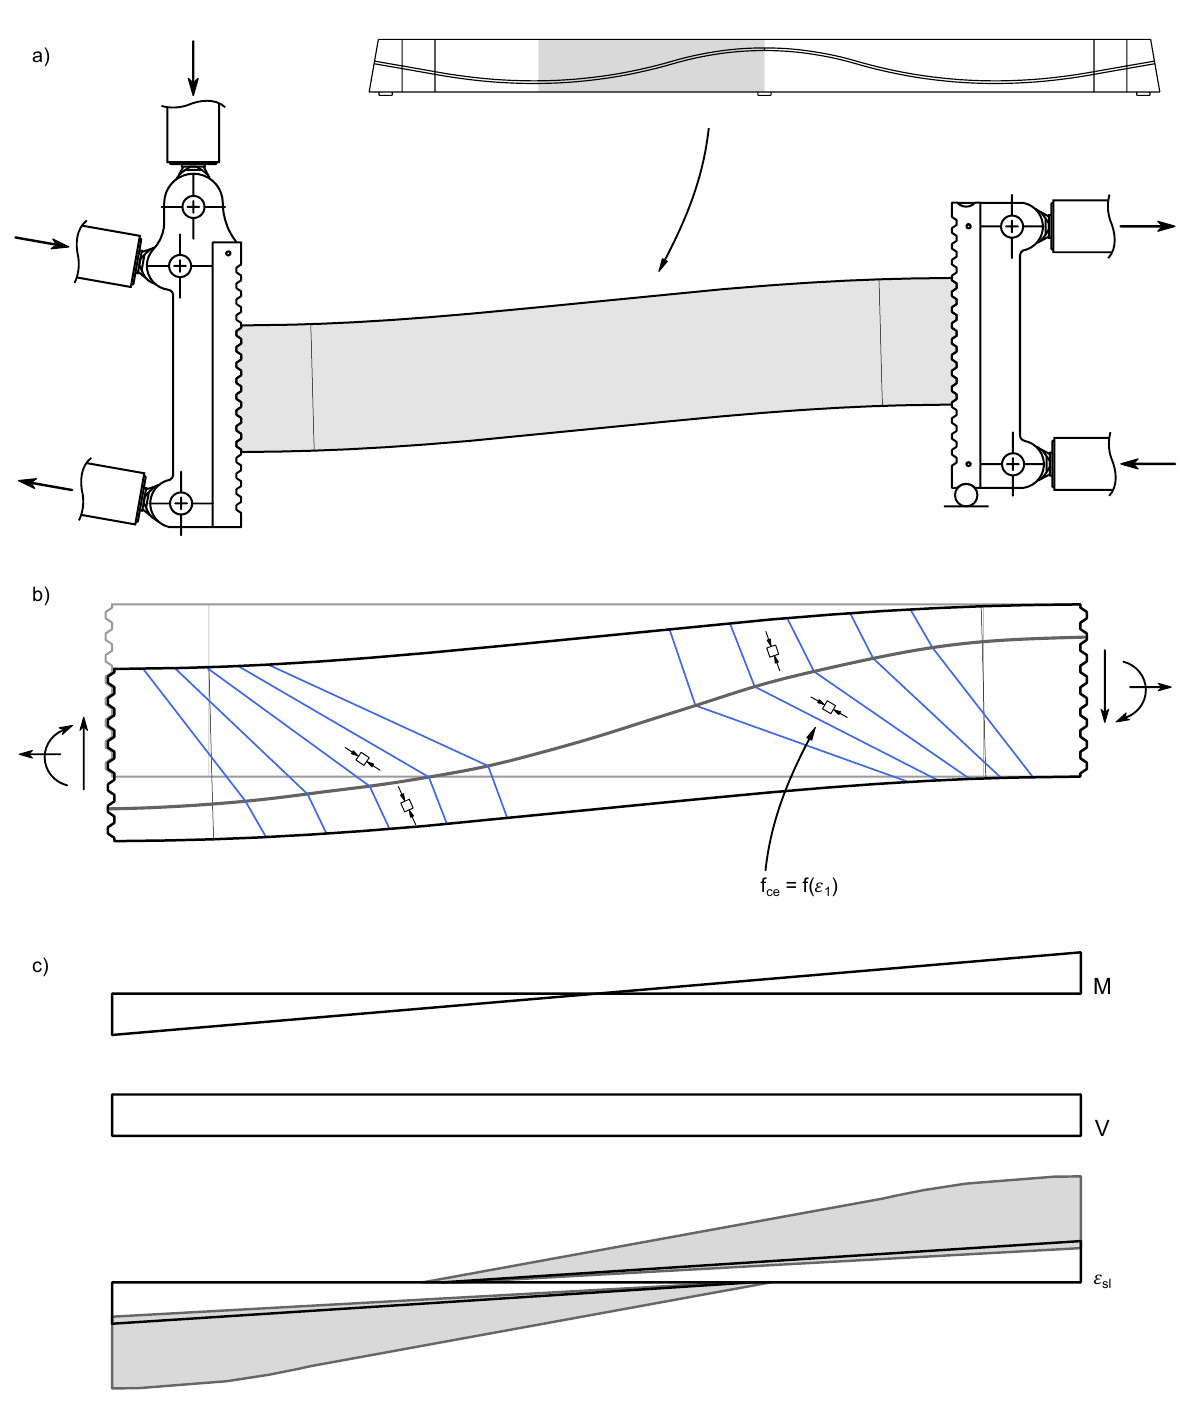
Figure 1. Experimental setup and focus of presented studies: a) Substructure technique for investigating the shear strength of prestressed beam elements, based on the shear field of a continuous beam between the point load in the span and the inner support. Reinforcement and tendons are anchored in tension in the cut edges/load plates; b) Deformed system and internal forces acting on it. The push cam profiling enables the transmission of shear forces in analogy to bridges in segmental construction. The fans of the cracked compressive stress field are indicated in the field and support areas, a deflection takes place at tendon axis. The effective web compressive strength, controlled by the reduction factor k c , is the focus of the presented investigations. Relevant details related to this factor are explained in the following section 3; c) Qualitative profile of bending moment and shear force in the tested beam element. The load is successively increased until a shear failure occurs. Under increasing load and a considerably reduced degree of longitudinal reinforcement, plastic strains result in the longitudinal reinforcement, which require a corresponding increase in strain in the tendons in order to guarantee the equilibrium of the internal